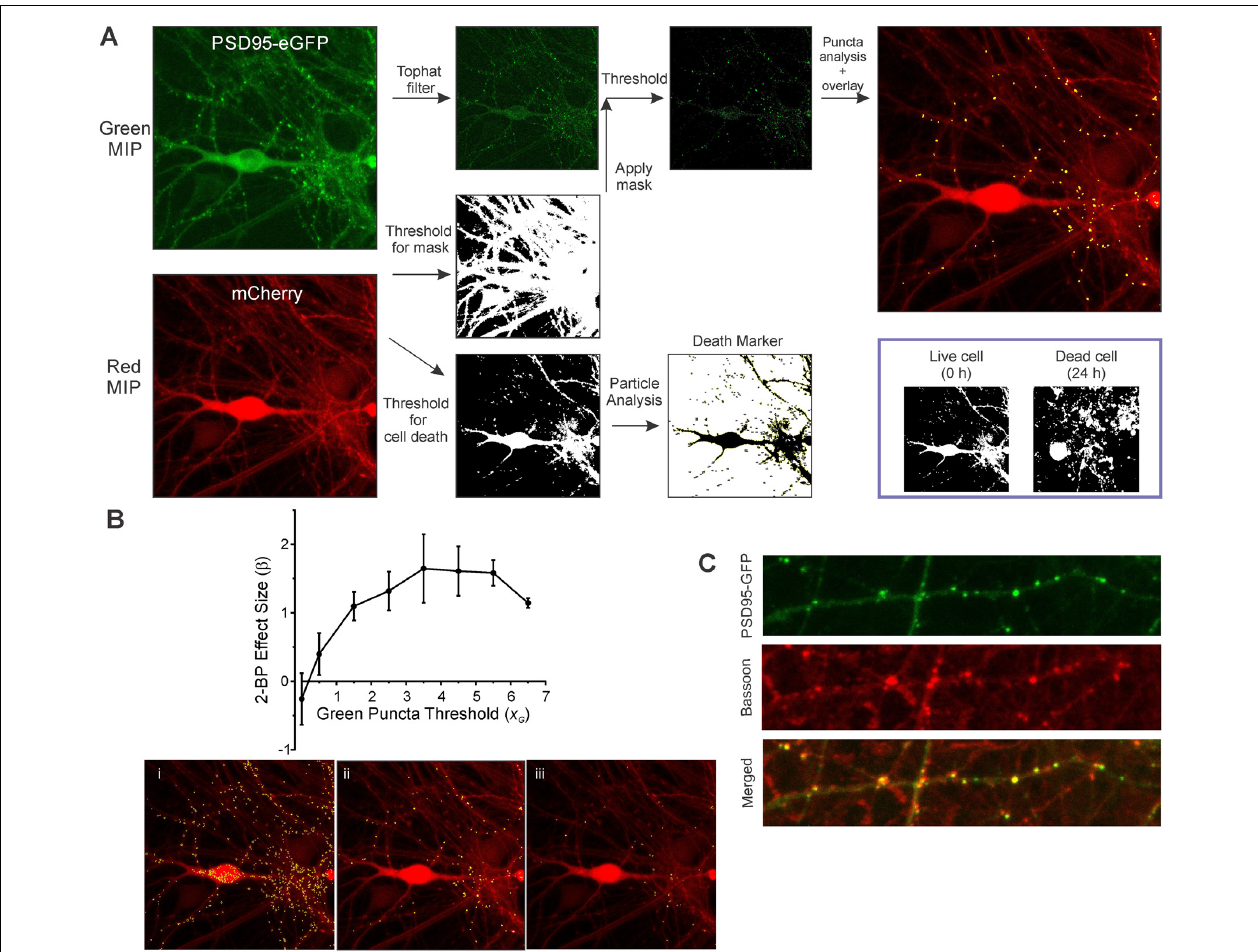
FIGURE 2 | Image analysis workflow. (A) MIPs for the red and green channels were generated from ROIs containing neurons transduced with HdAd-hSyn-PSD95-eGFP-hSyn-mCherry. A threshold equal to 0.5 × image mean intensity was applied to the red image to create a binary mask. A top hat filter was applied to the green image to enhance contrast. The red mask and the filtered green image were combined via a logical AND function to remove green structures that were not in contact with the cell defined by the red channel. A threshold equal to the image mean intensity + 3.5 × image SD was applied to create an image containing structures representing synapses. Puncta counted as synapses (8–80 pixels) are shown overlaid on the mCherry MIP. Finally, a second threshold equal to the mean + 0.25 × image SD was applied to the red MIP and the resulting image used for particle analysis. Inset, a binary image of a cell before and after 24 h exposure to 300 µ M glutamate is shown. Note that before treatment (0 h) much of the cell structure is intact and forms a contiguous structure. However, overt toxicity produces many small structures that result from the loss of membrane integrity as shown in the image collected at 24 h. (B) The optimal threshold setting for √ ( σ 2 + σ 2 counting green puncta was determined from the SSMD [ β = ( µ 1 − µ 2 )/ 1 2 )] for control (untreated) relative to 2-bromopalmitic acid (2-BP)-treated wells calculated from three separate 96-well plates. β is plotted vs. a scaling factor ( x G ) used to calculate the threshold which is defined as I green + x G (SD green ) where I green is the average intensity from the filtered green MIP and SD green is the standard deviation from the filtered green MIP. Representative processed images show counted puncta (yellow) overlaid on mCherry MIP for threshold settings where x G was equal to 1.5 (i) , 3.5 (ii) , and 5.5 (iii) . (C) Immunocytochemistry shows PSD95-GFP puncta co-localized with bassoon immunoreactive puncta. Neurons transduced with HdAd-hSyn-PSD95-eGFP-hSyn-mCherry were fixed and labeled with an antibody to bassoon as described in “Materials and Methods” section. Confocal images show PSD95-GFP (green channel), Bassoon immunoreactivity (far red channel) and merged image. Scale bar: 10 µ